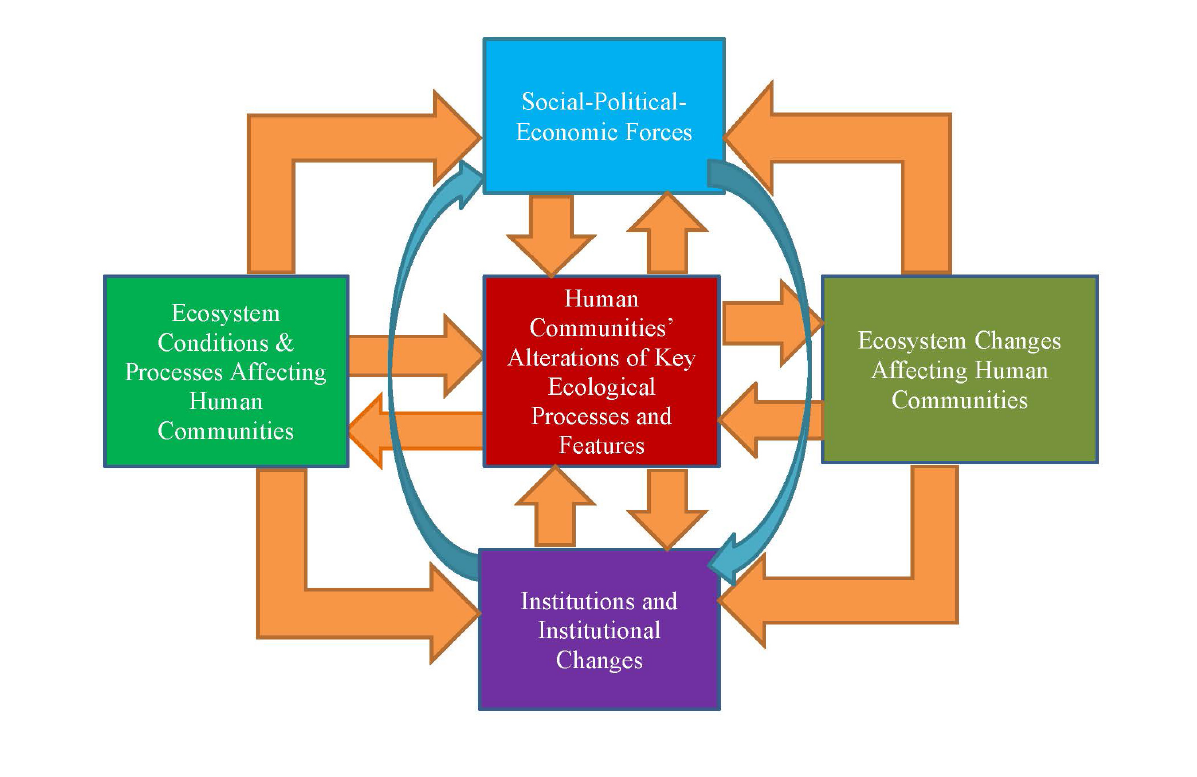
Fig. 1 . Framework of drivers of systemic